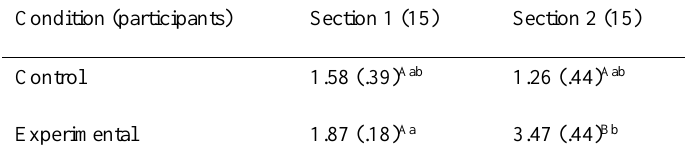
Mean Big Idea Ratings (and Standard Deviations) on Levels of Revelatory Strikingness Scale